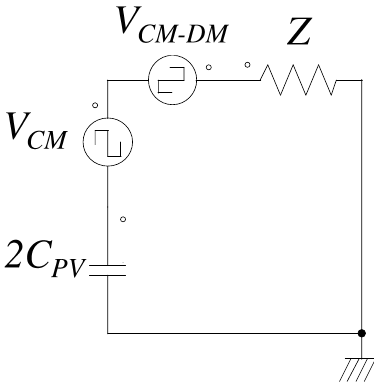
Figure 6. Simplest common-mode model for single-phase grid-connected inverter. where: V CM − DM indicates the influence of the differential mode voltage to the common-mode